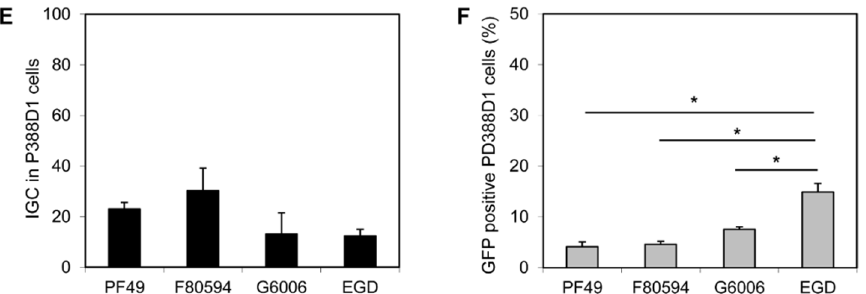
Figure 2. In vitro virulence. Intracellular growth coefficient (IGC) in human intestinal epithelial Caco-2 ( A ), mouse liver TIB-73 ( C ) and mouse macrophage-like PD388D1 cells ( E ) and cell-to-cell spread, shown as percentage (%) of GFP positive Caco-2 ( B ), TIB-73 ( D ), PD388D1 cells ( F ). * statistically significant difference ( p < 0.05).